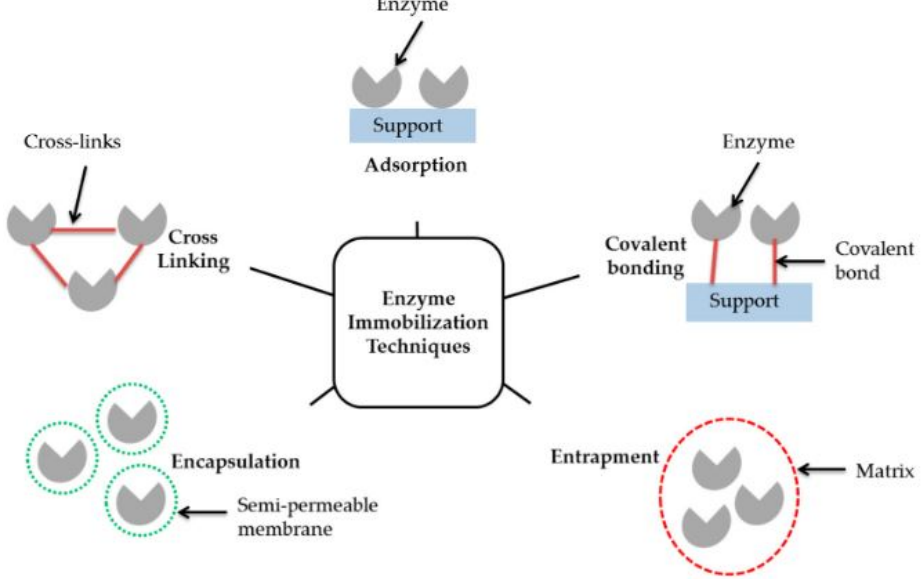
Figure 5. Enzyme immobilization methods. Reproduced with permission from Ref. [94] .